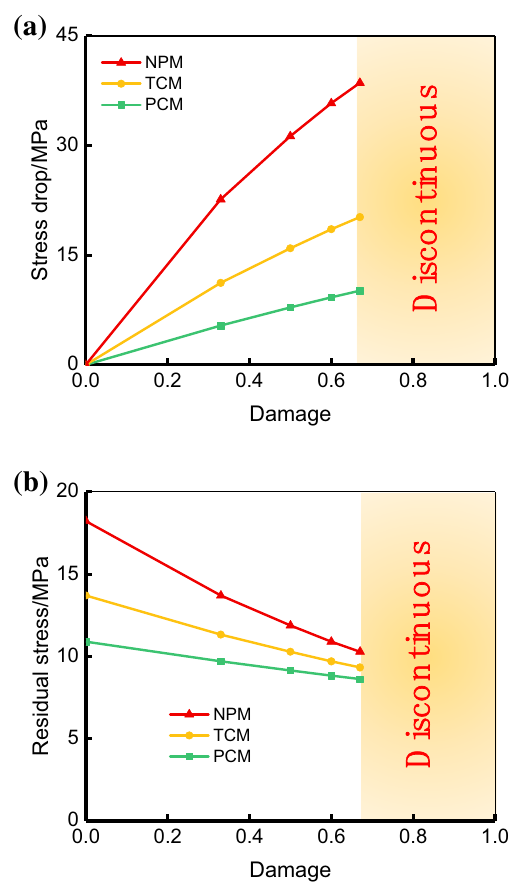
Fig. 5 Failure zone with increasing damage of a stress drop and b residual